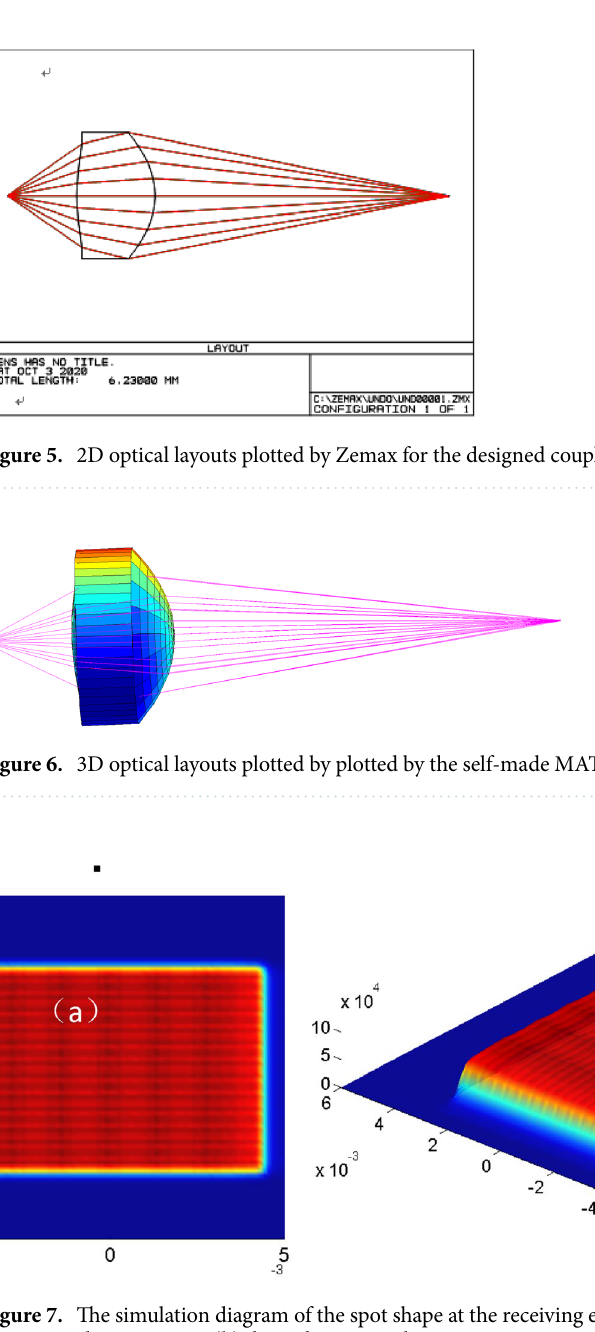
Figure 7. The simulation diagram of the spot shape at the receiving end face of the optical fiber, ( a ) two- dimensional spot pattern, ( b ) three-dimensional spot Figure 7 is the simulation diagram of light spot at the receiving end face of optical fiber plotted by using the self-compiled MATLAB program tracing 32,969,025 rays. It can be seen from Fig. 7 that the light spot is the same shape as the luminance surface. The size of light spot is about 9 µm × 6 µm, which indicates most of the light is within the fiber core ( d core = 9 µm). The light spot shape also manifest that the coupling lens not only plays a role of coupling but also has the imaging characteristics, and the vertical axis magnification of about 3 can be calculated from this spot, which is approximately equal to the vertical axis magnification 2.945195 shown in